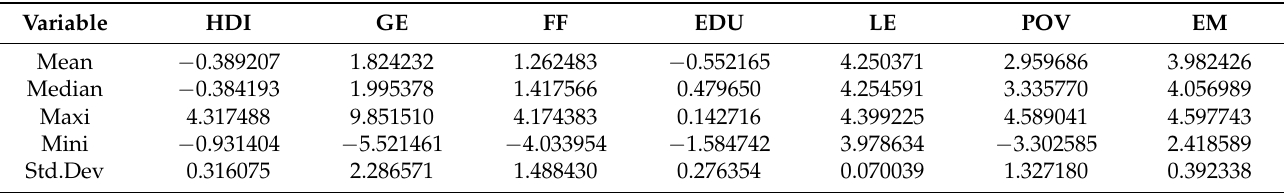
Table 4. Descriptive statistics of the variables.